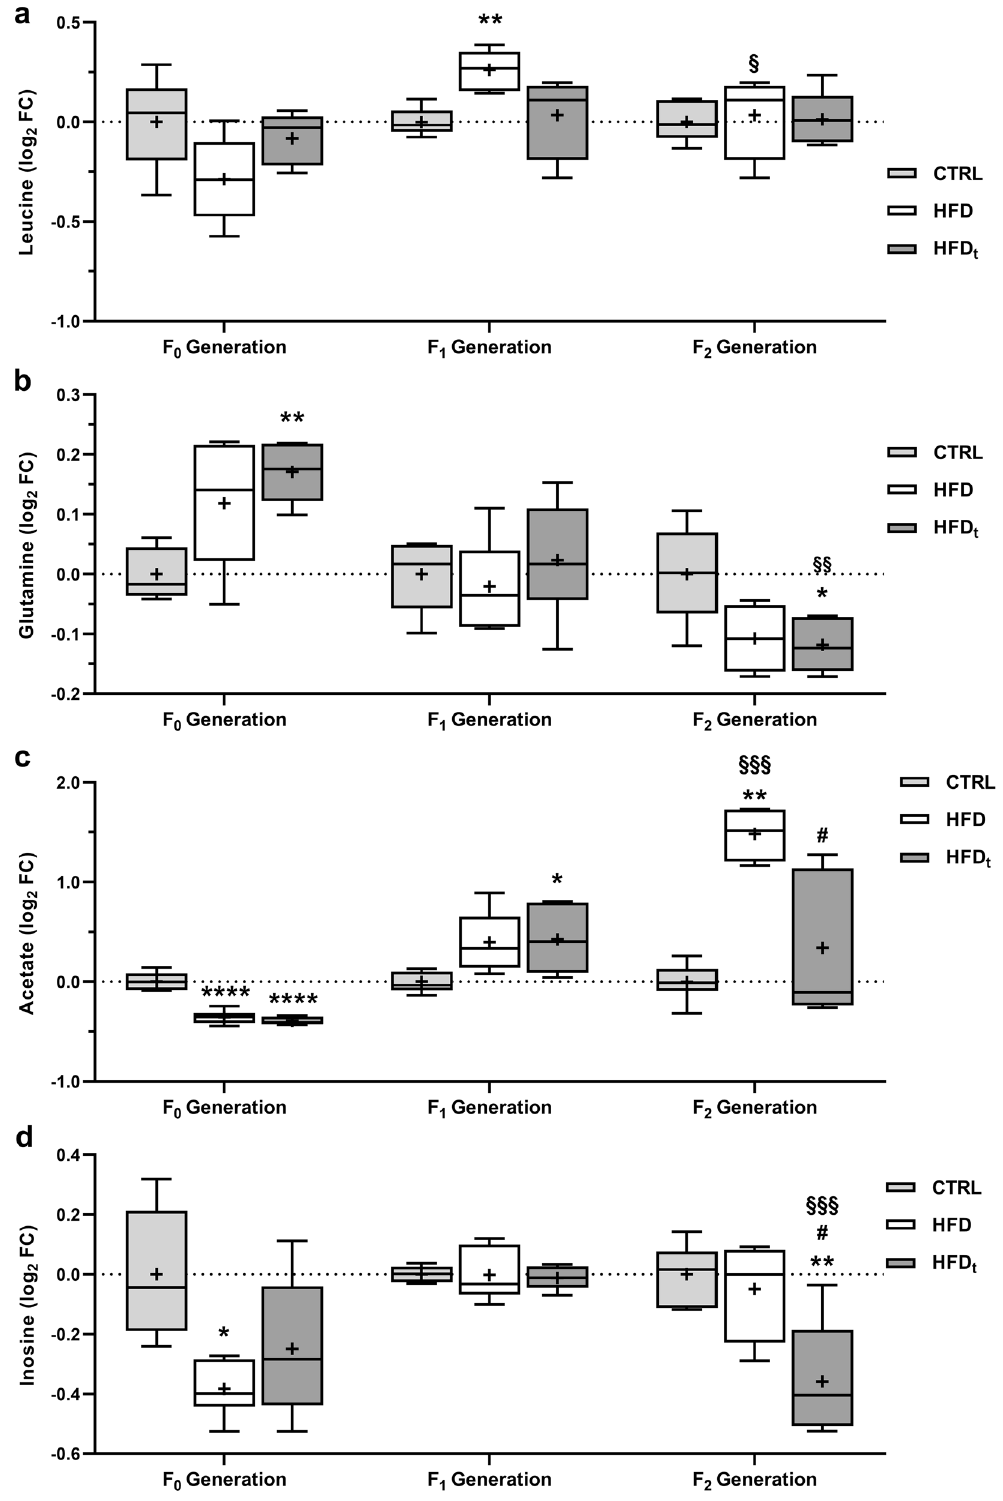
Figure 4. Testicular metabolites with variations across all generations (n = 6 per group in each generation). ( a ) Leucine; ( b ) Glutamine; ( c ) Acetate and ( d ) Inosine. Results are expressed as the log 2 Fold Change (FC) to the CTRL of the corresponding generation, as Tukey’s whisker boxes (median, 25th to 75th percentiles ± 1.5 Interquartile range). Metabolites were extracted from the testes collected during sacrifice (200 days after mice weaning). Data was tested by univariate ANOVA with Tukey’s HSD for pairwise comparisons. Two-way ANOVA with Šidak correction was used to compare each diet group in F 1 Generation against its F 2 counterparts. Graphs were obtained using the software GraphPad Prism 8 (San Diego, CA, USA). Pairwise significance was considered when p < 0.05. * vs. CTRL; # vs. HFD; § vs. F 1 Generation. Multiple significance signs represent different significance levels: *p < 0.05; **p < 0.01; ***p < 0.001; ****p < 0.0001. + Group